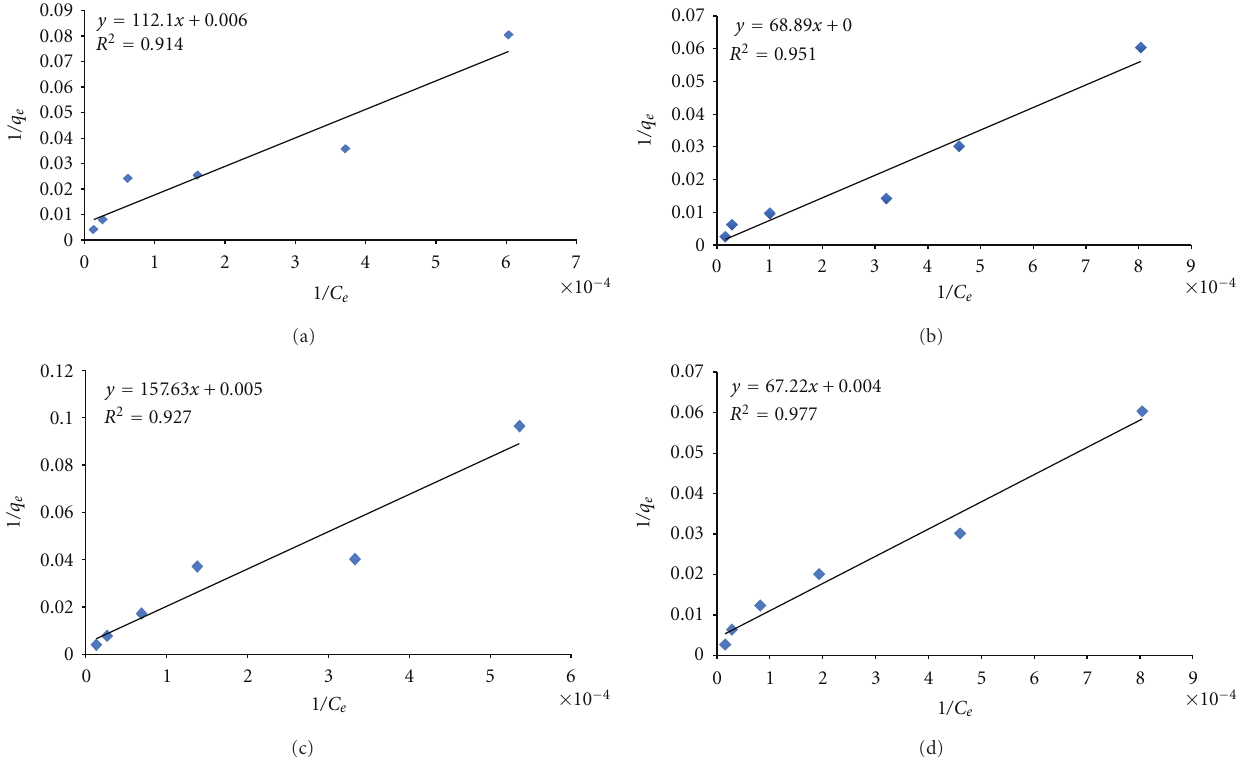
Figure 3: Langmuir’s adsorption isotherms of lead sorption by hybrid active carbons (a) Ox-AC, (b) Ox-AC-BY, (c) Rd-AC and (d) Rd-AC- BY.